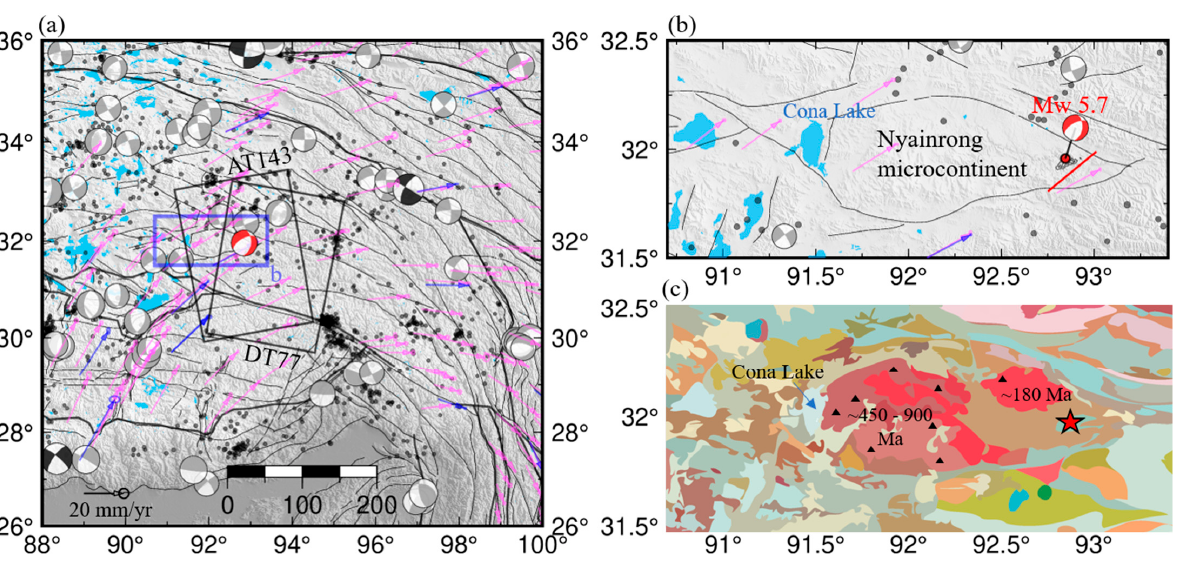
Figure 1. ( a ) Regional seismotectonic context around the 2021 Nagqu Mw 5.7 earthquake. Red focal mechanism is the hypocenter of the 2021 Nagqu event. Gray focal mechanisms are historical events with Mw > 5.5 from Global Centroid Moment Tensor (GCMT) [7]. Black focal mechanisms are Mw > 7 historical earthquakes. Black dots are historical earthquakes with Mw between 4 and 5.5. Purple and black vectors are, respectively, continuous and campaign Global Navigation Satellite System (GNSS) velocities from 1998 to 2014 [8]. Blue polygons are lakes with area larger than 1 km 2 from National Tibetan Plateau Data Center [9]. Black rectangles represent the spatial coverages of Sentinel-1 SAR data from one ascending track 143 (AT143) and one descending track 77 (DT77). Blue rectangle bounds the extent of enlarged ( b ). ( b ) The zoom-in of blue box in ( a ). ( c ) Geological map covering a similar region of ( b ) modified from the 1:1.5 million geological maps of the Tibetan Plateau and detailed lithology properties are available[10]. The lithology age marked in ( c ) is adopted from Xie et al. (2014) [2].